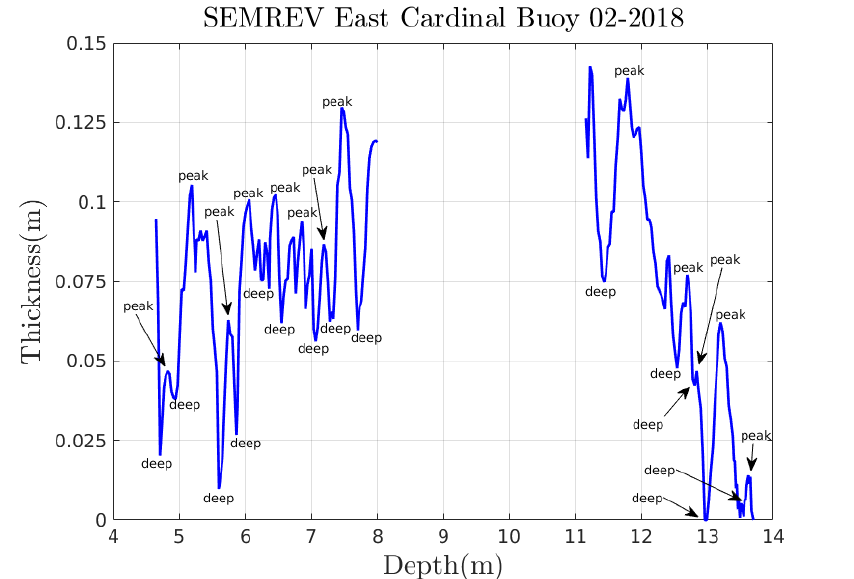
Figure A2. Two sub-trajectories on the mooring line of the East cardinal buoy in February